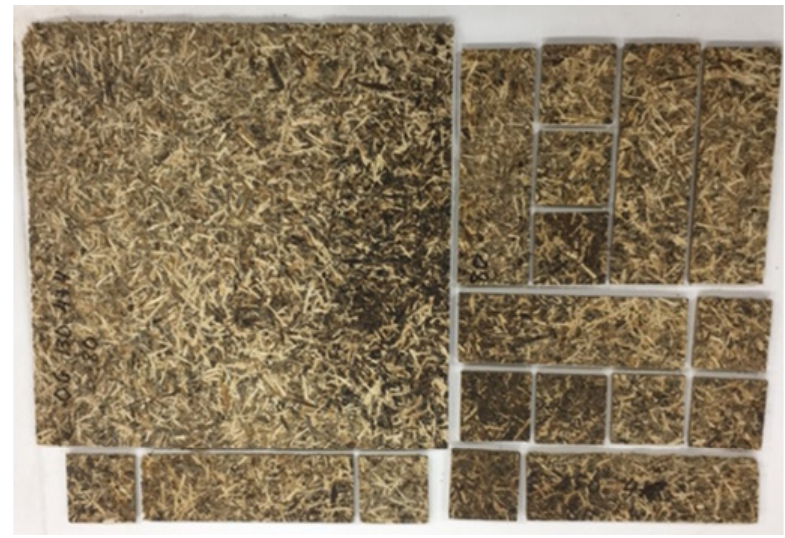
Figure 3. Specimens for the different tests.